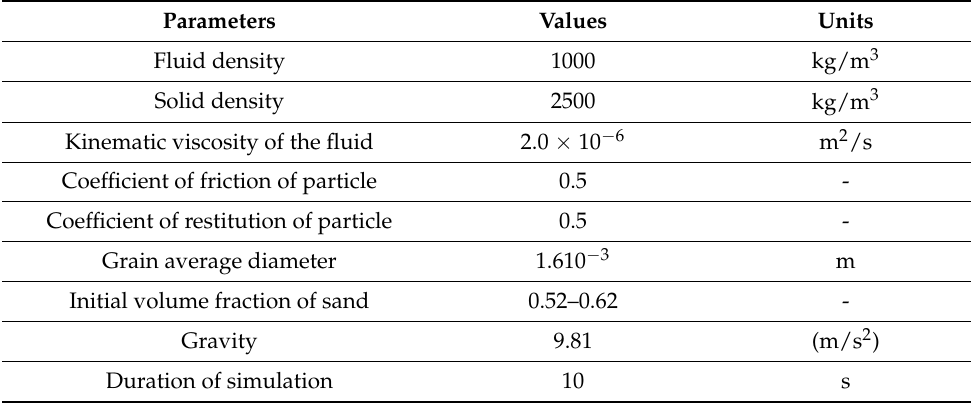
Table 1. Fluent-EDEM simulation parameters used for the